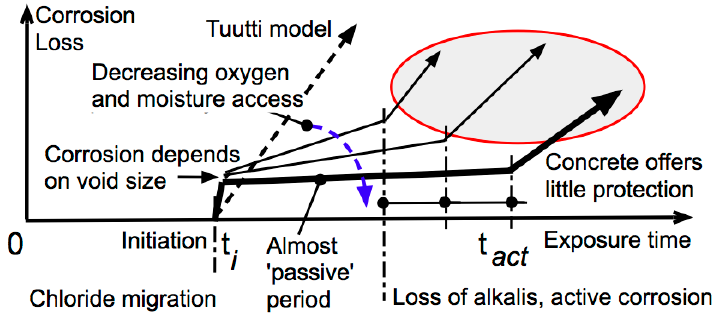
Figure 1. Model for the progression of reinforcement corrosion in concretes of various qualities, with low permeability concrete showing little progression of corrosion after t i , and until t act at which time a serious loss of concrete alkalis had occurred. The bold trend applies for high quality, low permeability concrete. The Tuutti model [8] is the conventional model that assumes t i defines the commencement of serious corrosion damage initiated by an excessive chloride concentration. © R.E. Melchers 2020.